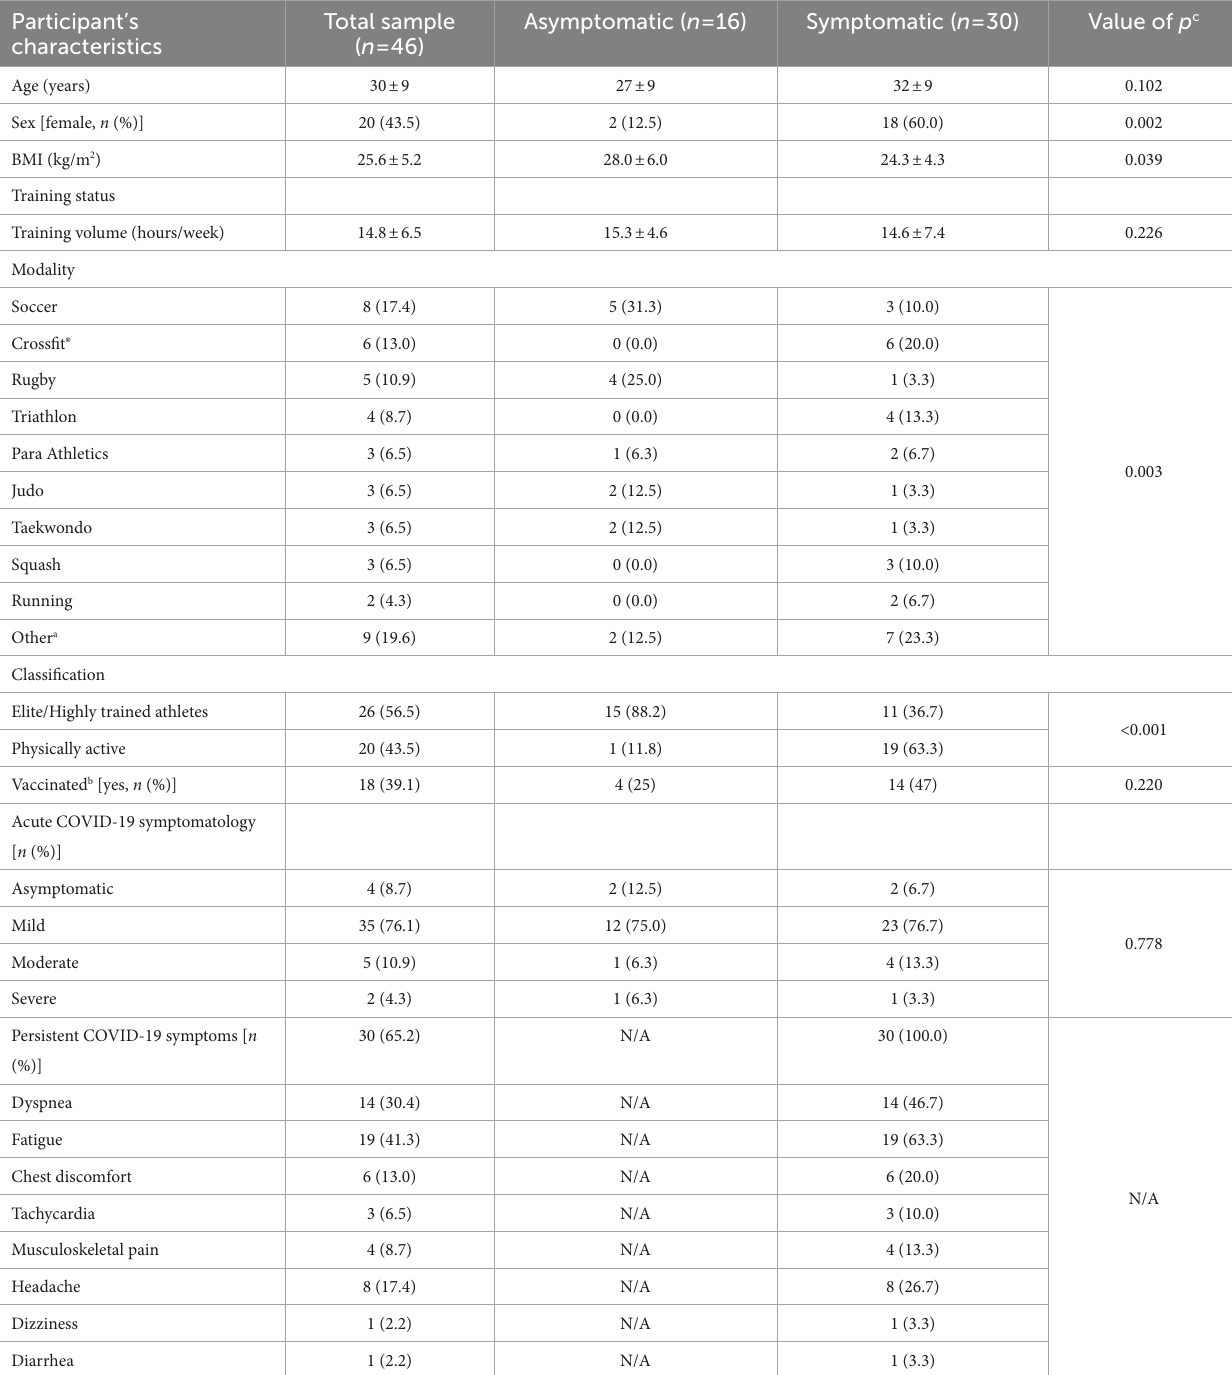
TABLE 1 Participants’